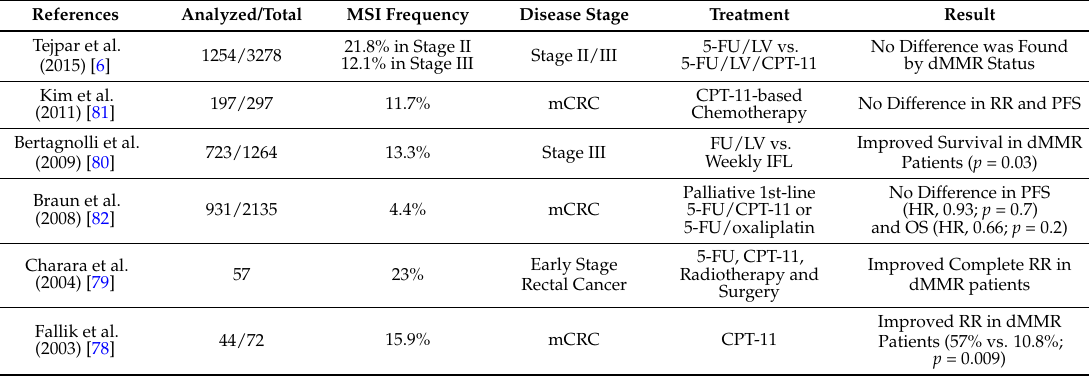
Table 2. Studies assessing the impact of MMR status on the efficacy of CPT-11 in CRC